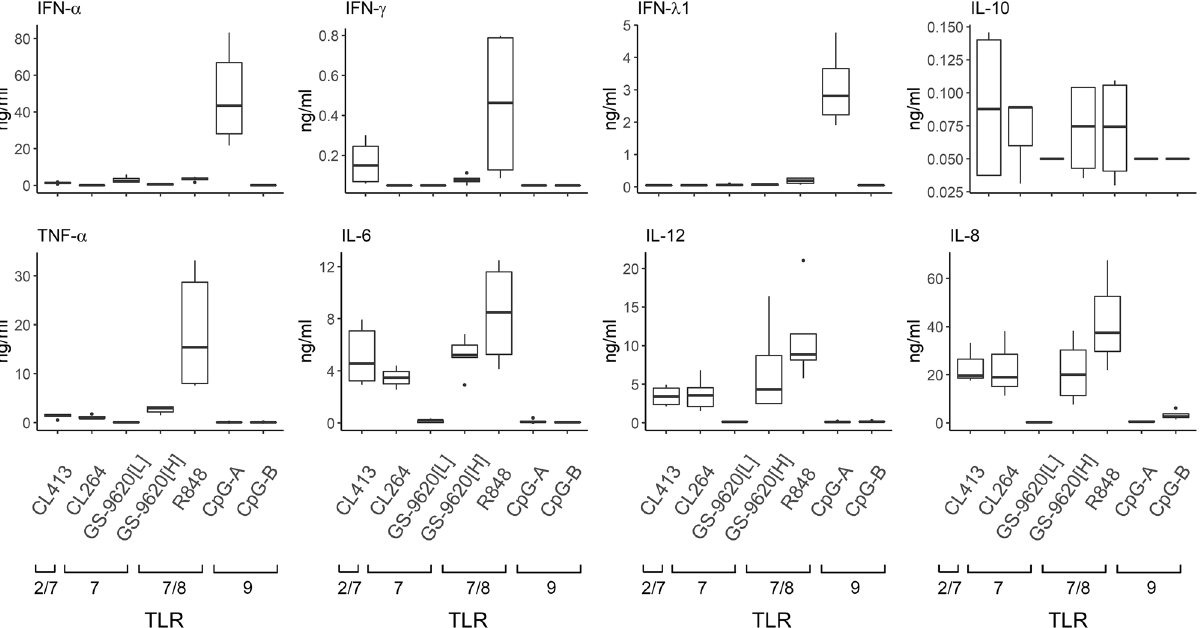
Figure 1. Cytokines secreted by PBMCs stimulated by different TLR2/7, TLR7, TLR7/8 and TLR9 agonists. PBMCs (N > 3) were stimulated with the TLR2/7 dual-agonist CL413 (5 µg/ml), the TLR7 agonists CL264 (5 µg/ ml) and GS-9620[L] (50 nM), the TLR7/8 agonists GS-9620[H] (10 µM) and R848 (4 µg/ml), and the TLR9 agonist CpG-A (4 µg/ml) or CpG-B (4 µg/ml) for 16 h, and the cytokine levels were determined by ELISA. The data are shown as medians and interquartile ranges. See Supplementary Fig. S1 for logarithmic